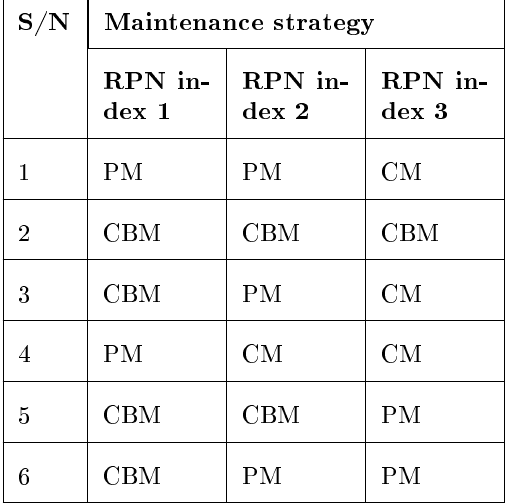
Tab. 13: Failure modes maintenance strategy.